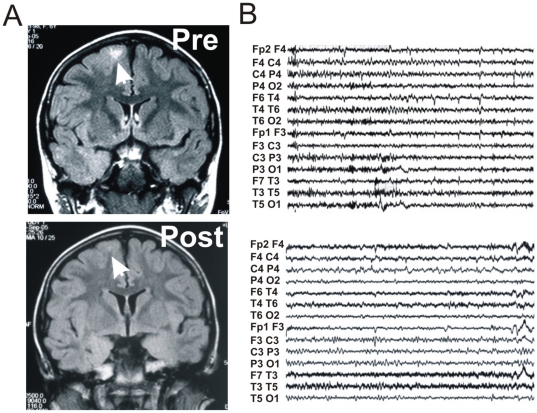
Radiologic indices of successful treatment with dexamethasone.The seizure reducing effect of dexamethasone (B) was paralleled by a decrease in FLAIR hyperintensity.